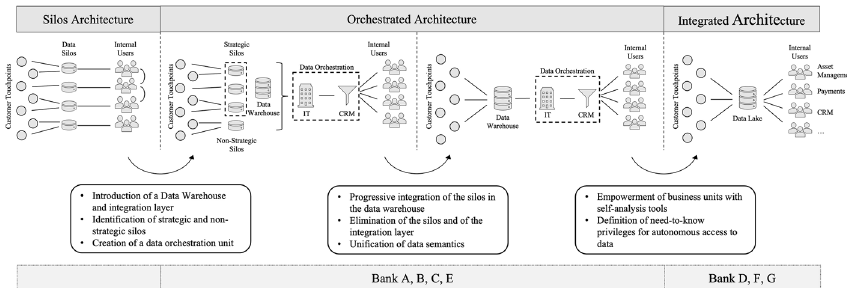
Fig. 3 Representation of the technological architecture configuration from a silo to an integrated architecture. Internal users are the different internal units that consume the data (e.g. lending, asset management, compliance and risk management). Banks A, B, C and FinTech E have an orchestrated architecture, while Bank D and FinTechs F and G have an integrated